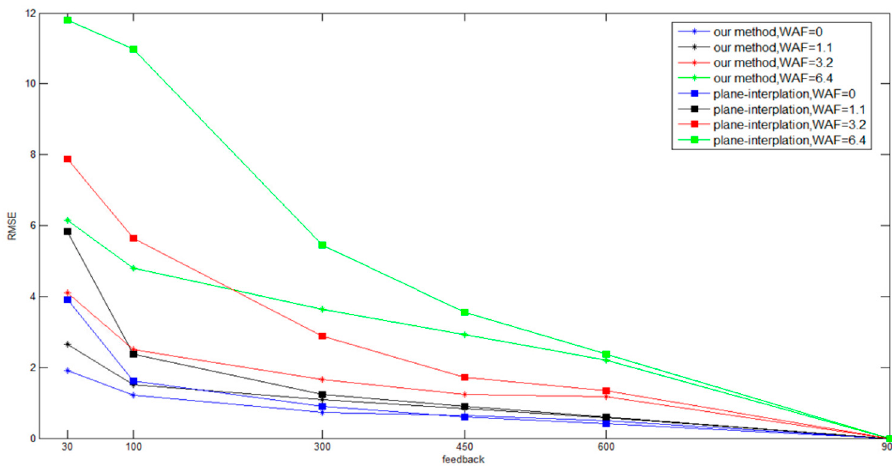
Figure 8. Comparison results with different methods.